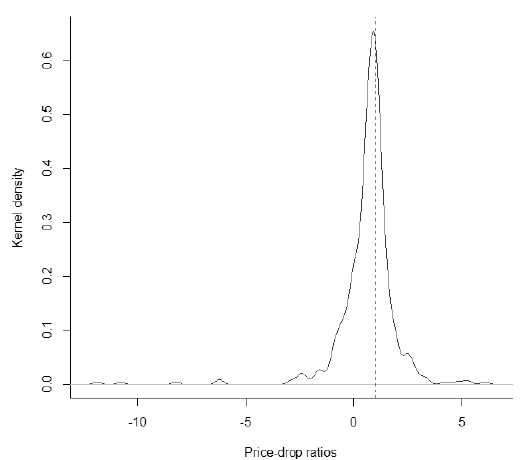
Figure A1. Kernel-density estimate of price-drop-ratio distribution (bid). This figure depicts a kernel-based estimate of the distribution of price-drop ratios (PDRs) based on closing bid prices. The PDR is defined as the adjusted drop from the closing bid price on the dividend date to the closing bid price on the ex-date over the dividend payment of a stock. The sample includes all constituents with tax-free dividends of the German CDAX index between January 2002 and September 2019. Due to missing bid prices, only 450 of all 456 dividend events in the data are included. Epanechnikov kernel density. Data source: Refinitiv EIKON.